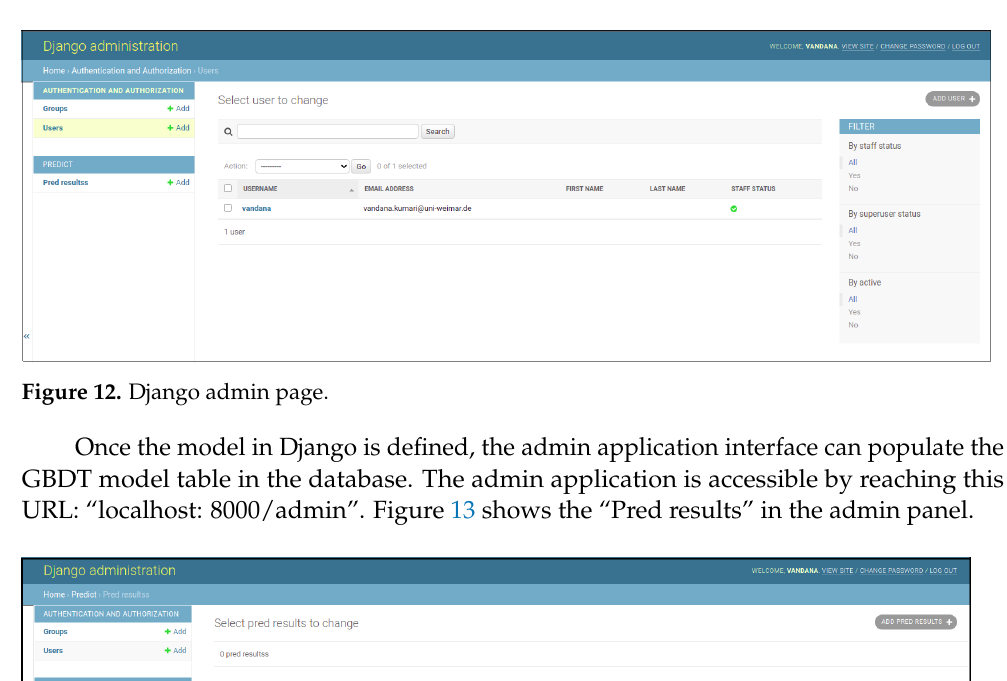
Figure 11. The home page with input fields and the submit button.